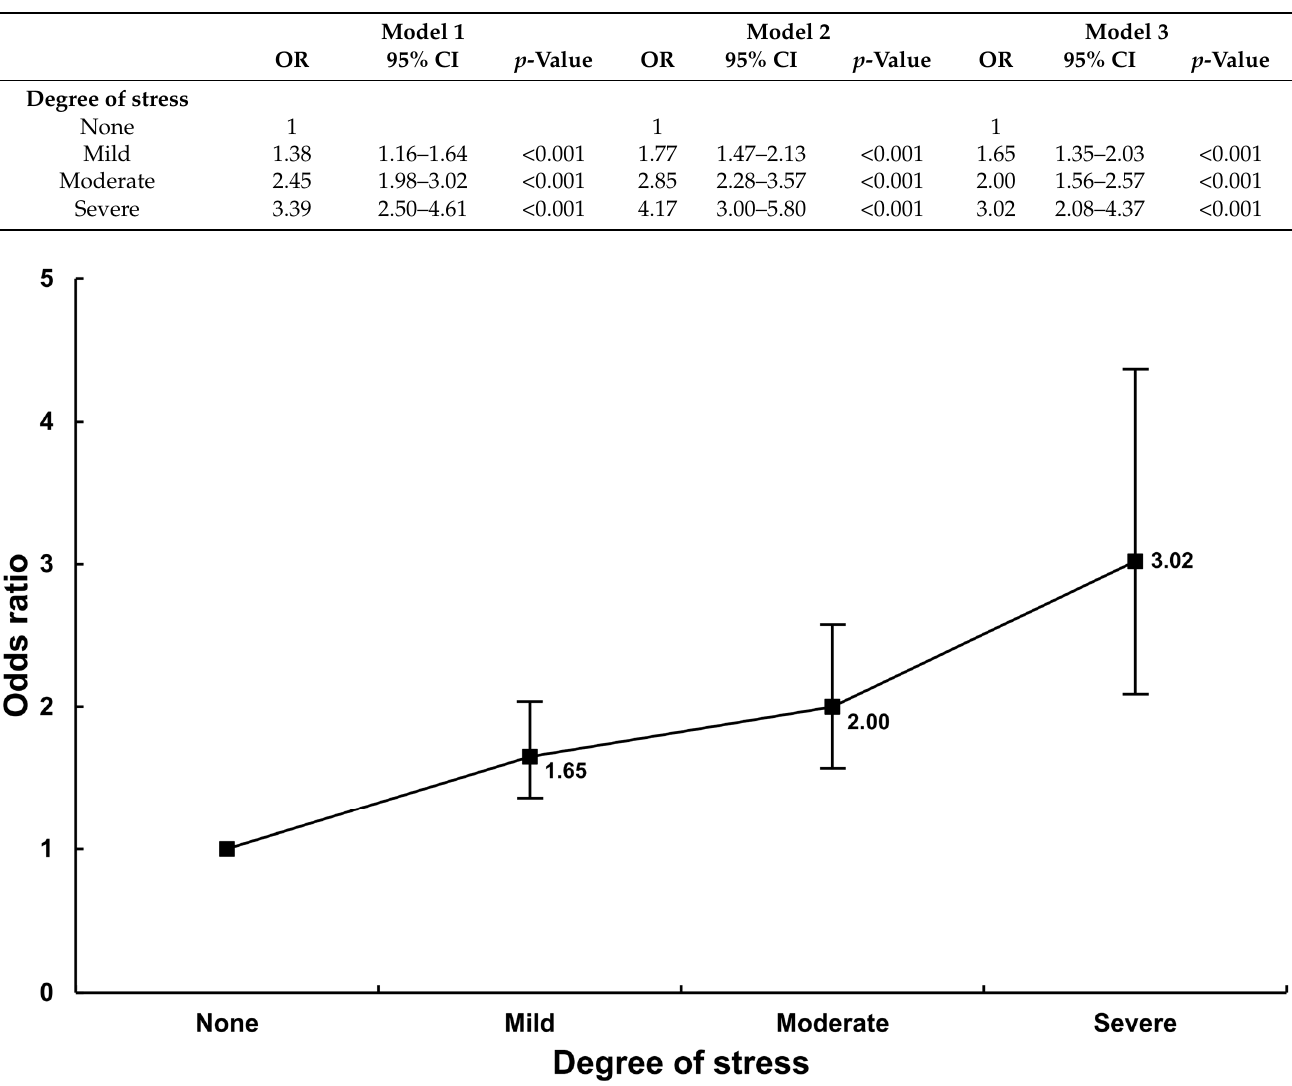
Table 2. Association between CKP and psychological stress using multiple logistic regression.